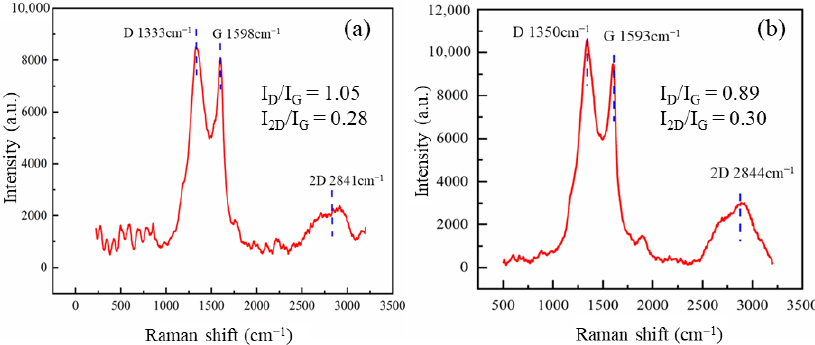
Figure 8. Raman spectra for ( a ) hot-pressed; and ( b ) extruded composites.